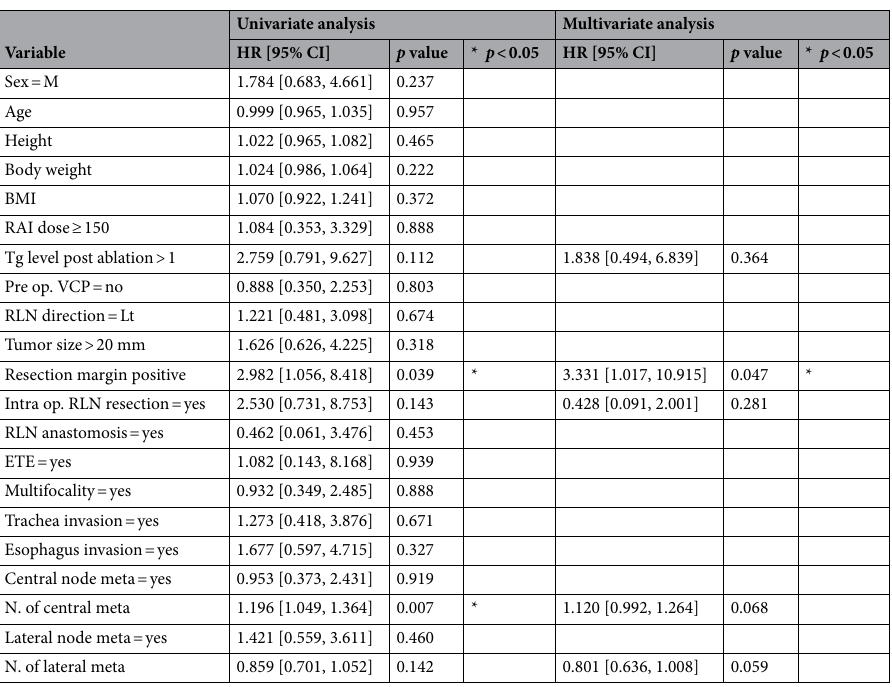
Table 4. Factors predictive of recurrence by univariate and multivariate analysis. † HR : Hazard ratio, SD : Standard deviation, RAI : Radioactive iodine, Tg : Thyroglobulin, VCP : Vocal cord palsy, RLN : Recurrent laryngeal nerve, ETE : Extrathyroidal